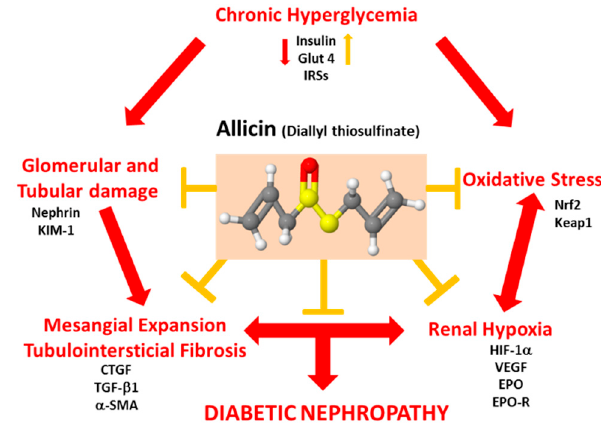
Figure 10. E ff ects of allicin on pathophysiological mechanisms during progression of nephropathy associated to diabetes. Structure of allicin (diallyl thiosulfinate): red spheres, oxygen; yellow spheres, sulfur; gray spheres, carbon; white spheres,